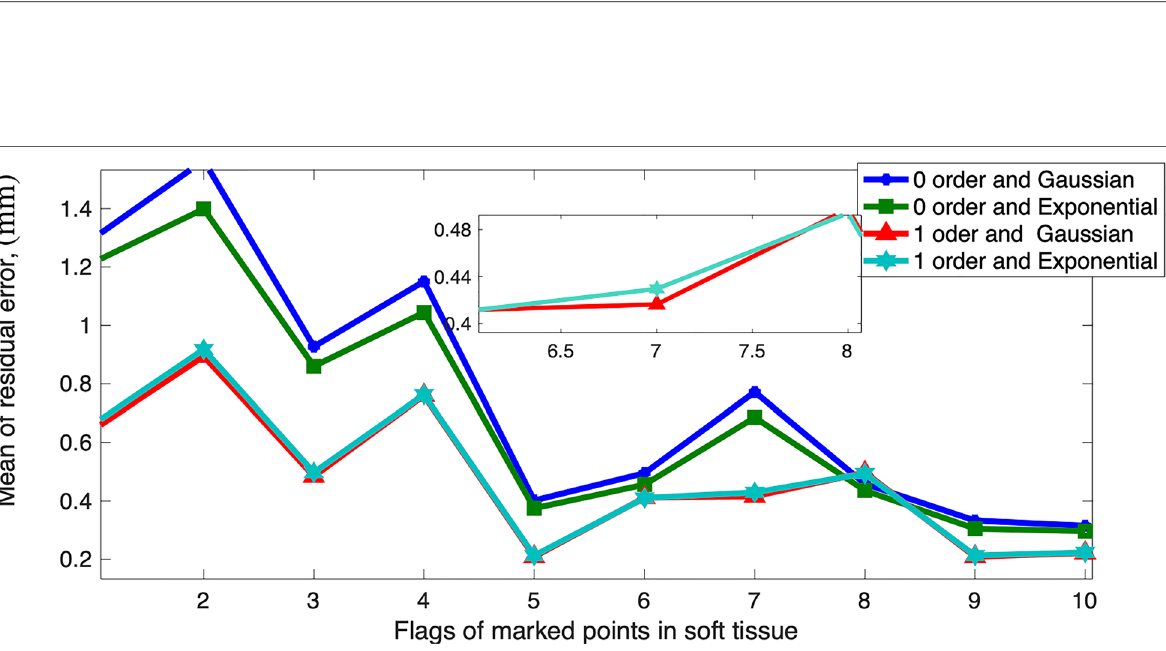
Figure 4 The mean residuals of the Kriging predictions for four different